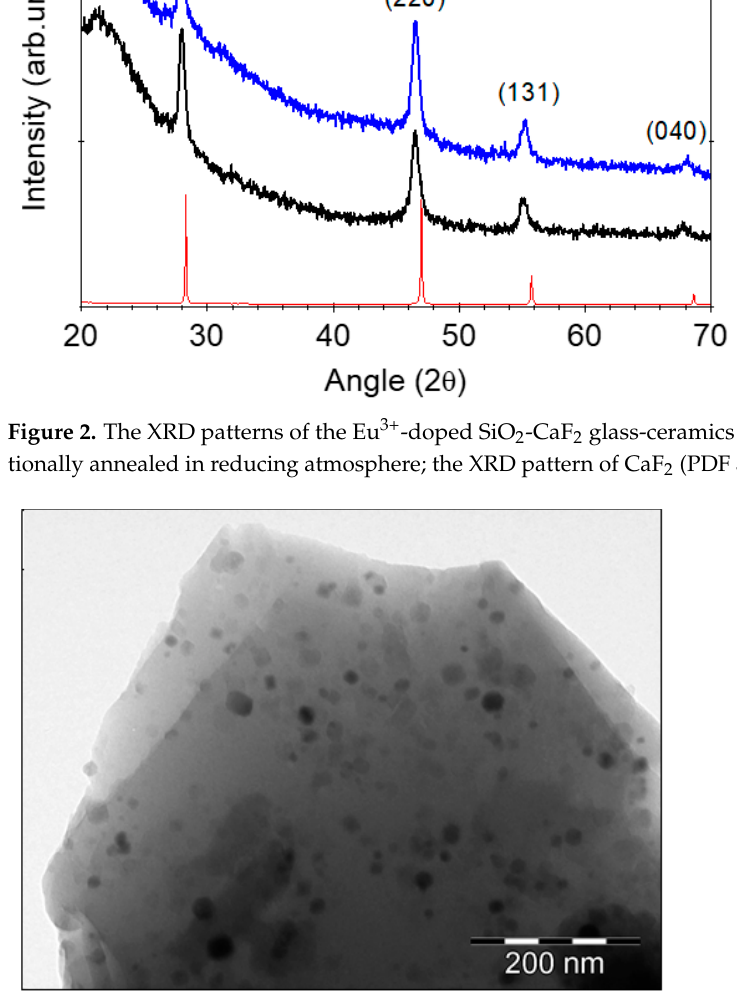
Figure 3. Transmission electron microscopy image of a Eu 3+ -doped SiO 2 -CaF 2 glass-ceramic grain annealed in air (reproduced from Ref. [12]).